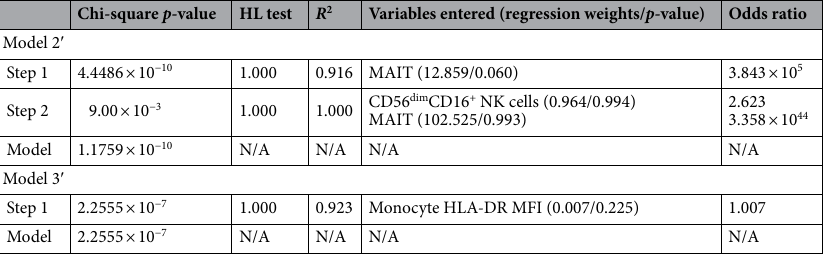
Table 3. Optimized multivariate immune profiles for predicting COVID-19 disease severity using binary logistic regression. R 2 Nagelkerke’s pseudo- R 2 , HL Hosmer–Lemeshow